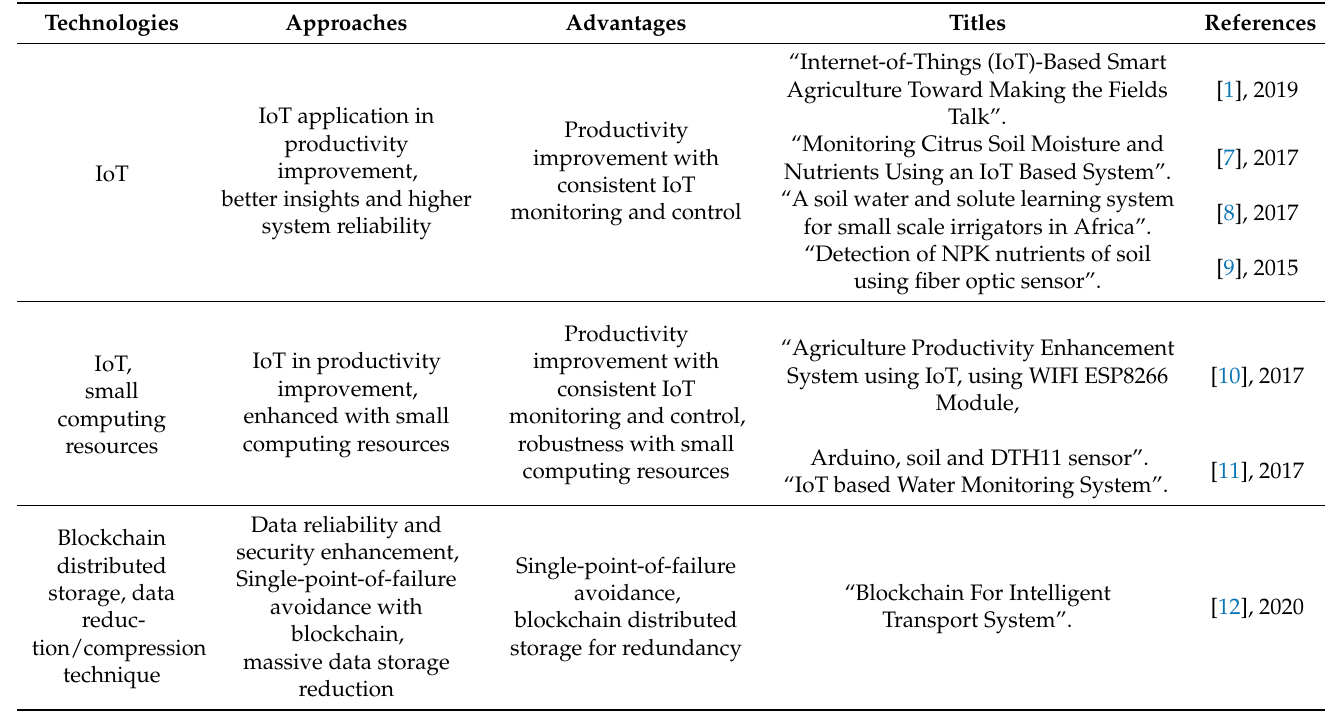
Table 2. IoT productivity improvement related research